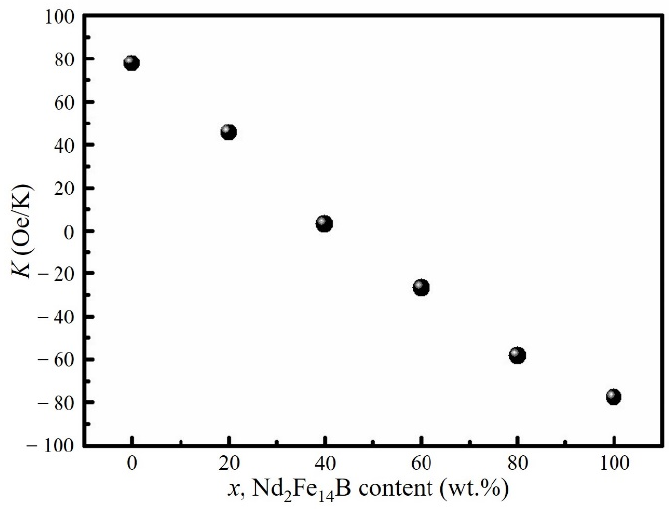
Figure 5. The temperature dependence of coercivity of the bulk (Mn 55 Bi 45 ) 100 − x /(Nd 2 Fe 14 B) x ( x = 0, 20, 40, 60, 80, and 100) hybrid magnetic alloys. Figure 6. The temperature coefficient of coercivity of the bulk (Mn 55 Bi 45 ) 100 − x /(Nd 2 Fe 14 B) x ( x = 0, 20, 40, 60, 80, and 100) hybrid magnetic alloys.